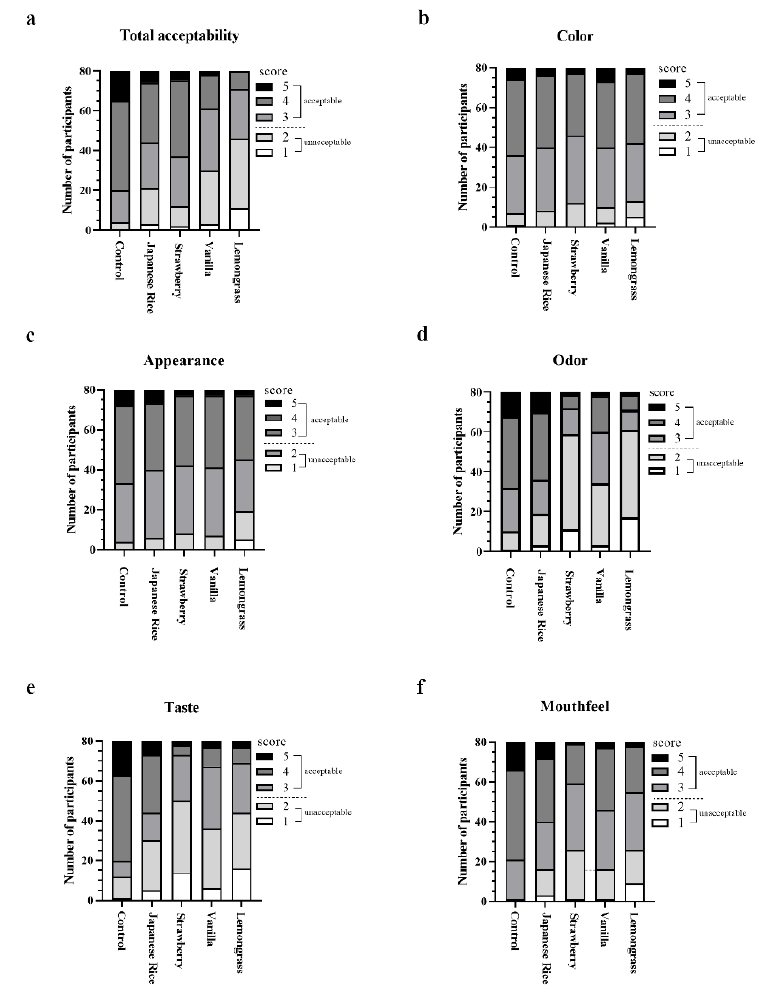
Figure 5. Acceptability of fortified formulas with different flavors. The stacked bars show the number of participants who assigned different scores on 5-point hedonic scales from 1 to 5 for total acceptability ( a ), color ( b ), appearance (c), odor ( d ), taste ( e ), and mouthfeel ( f ) of the fortified formula with Japanese rice, strawberry, vanilla, and lemongrass flavors. A score above 3 is